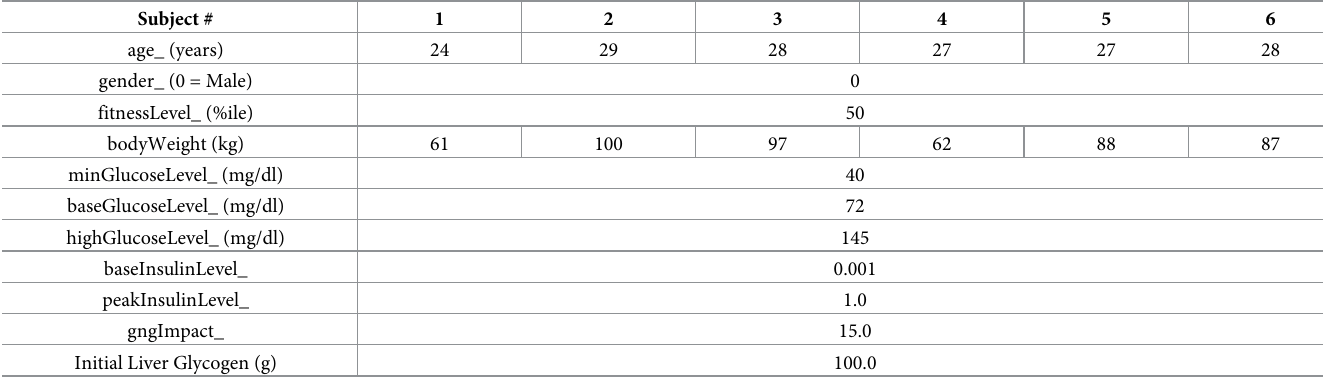
Table 9. Configuration parameters for simulations for a single “arm” exercise event at intensity 30% VO 2 max .